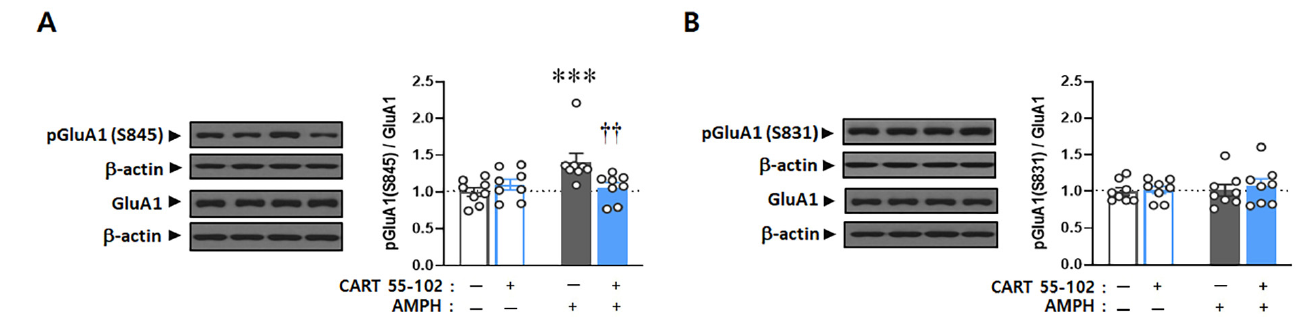
Figure 3. Microinjection of CART peptide 55–102 into the NAcc core inhibits the AMPH-induced increase of GluA1 phosphorylation levels at serine 845 but not at serine 831. ( A , B ) Representative Western blots of total and two phosphorylated forms (S845 and S831) of GluA1 are shown. Values for the band intensities were first normalized to β -actin, and the average values for the ratio of phosphorylated to total proteins in each group are expressed as mean (+S.E.M.) relative to saline microinjection + saline IP injected group. Symbols indicate significant differences, as revealed by post hoc Tukey comparisons following two-way ANOVA. *** p < 0.001, significant differences between saline microinjection. †† p < 0.01, significant differences within AMPH IP injection. The number of rats in each group is 8.